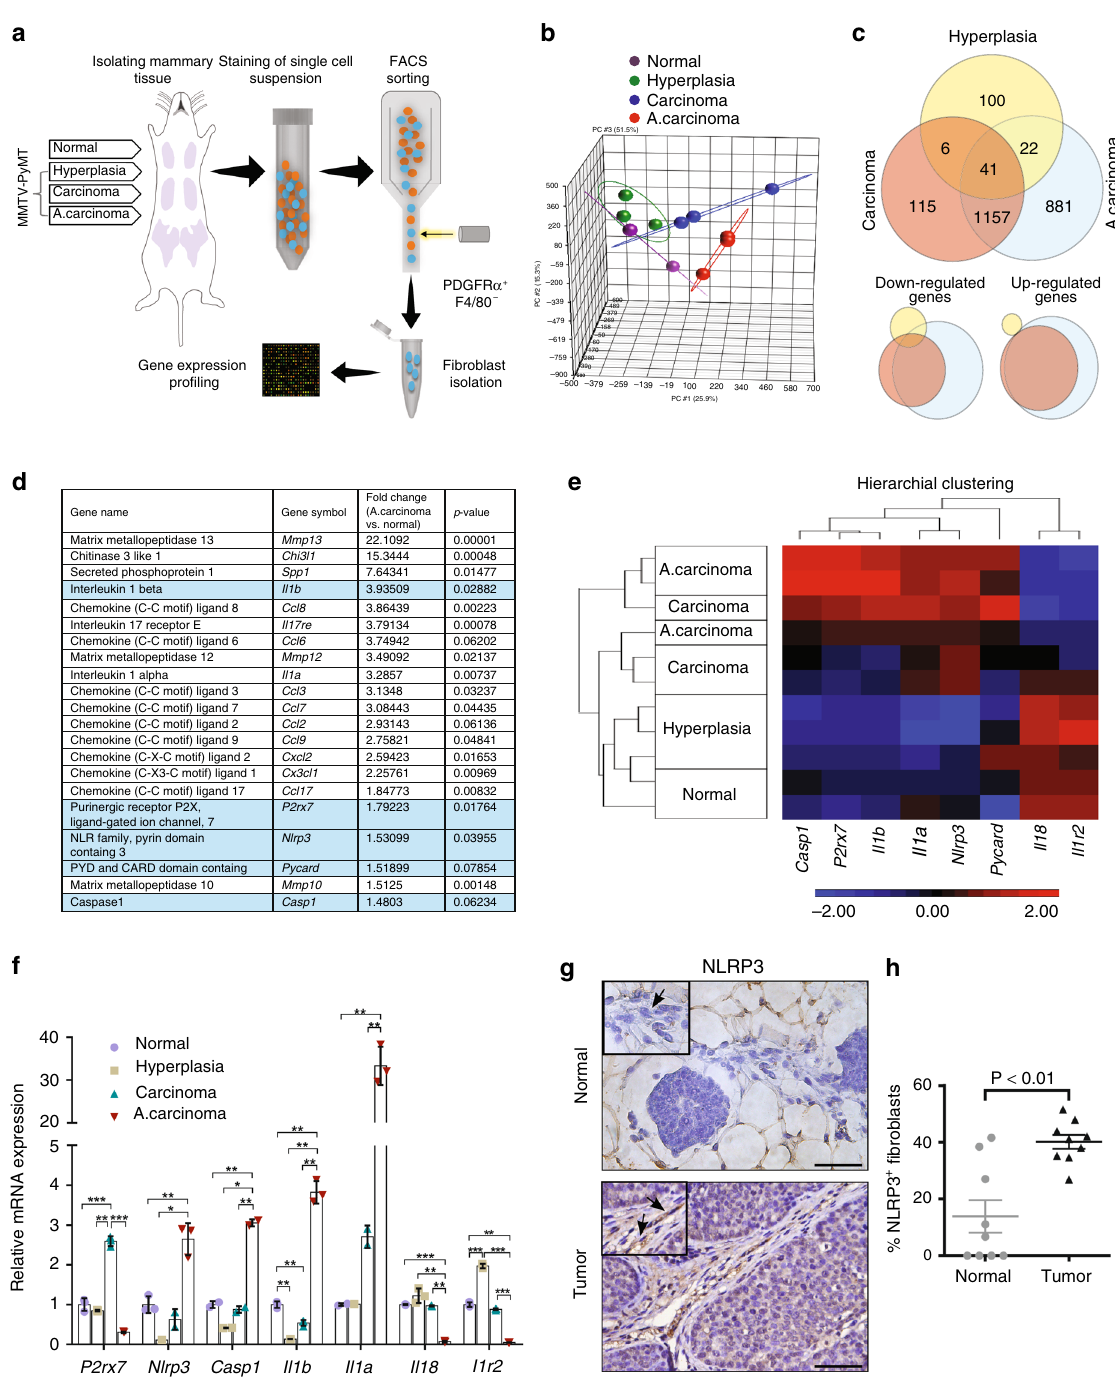
Fig. 1 The NLRP3 in fl ammasome pathway is upregulated in fi broblasts during mammary carcinogenesis. a Scheme of fi broblast isolation procedure. b Principal component analysis (PCA) of samples included in the microarray transcriptome analysis. Each focal point represents a cohort of mice. Normal n = 6 mice/cohort, Hyperplasia n = 6 mice/cohort, Carcinoma n = 4 mice/cohort, advanced carcinoma (A. Carcinoma) n = 3 mice/cohort. c Venn diagrams depicting overlap of differentially expressed genes in fi broblasts isolated from distinct stages of MMTV-PyMT mammary carcinoma. d Pro- in fl ammatory genes upregulated in CAFs isolated from MMTV-PyMT tumours. In fl ammasome-related genes are highlighted. e Heat map of Nlrp3/Il1b pathway-related genes. f qRT-PCR analysis of Nlrp3/Il1b pathway related genes in fi broblasts isolated by FACS (PDGFR α + CD45 − EpCAM − ) from MMTV- PyMT mice or normal mammary glands. Data are presented as mean ± s.d of technical repeats; One-way analysis of variance followed by Tukey ’ s test. * p < 0.05, ** p < 0.005, *** p < 0.0005, n = pools of 3 mice/group. Results are representative of three independent biological experiments. g Representative IHC staining of NLRP3 in PyMT tumours or in normal mammary glands. Arrows indicate fi broblasts. Scale bar, 25 µ m. h Quanti fi cation of staining shown in g . Multiple fi elds of 3 mice/group were analysed for the percentage of NLRP3 expressing fi broblasts out of total fi broblasts. Data are presented as mean ±